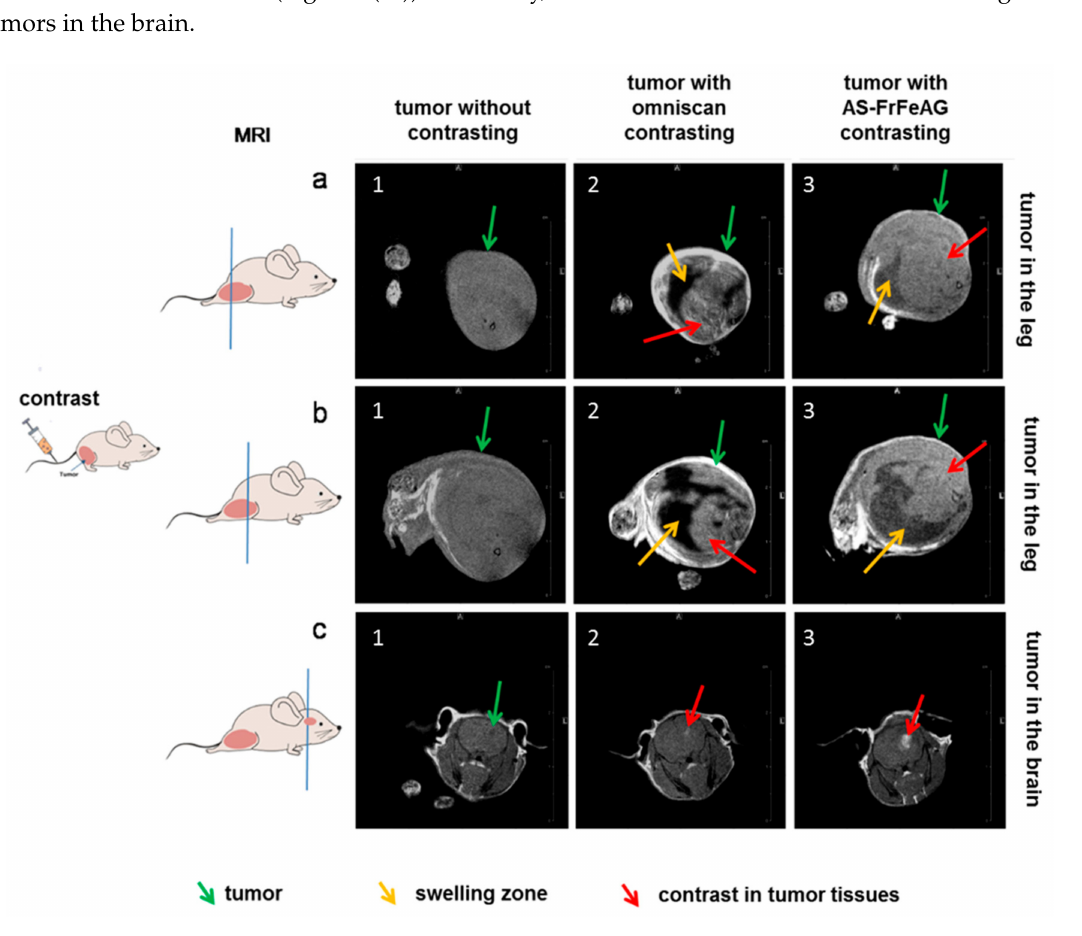
Figure 6. Application of AS-FrFeAG as a contrast agent for tumors in magnetic resonance imaging (MRI). A mice with solid Ehrlich carcinoma transplanted into the right leg ( a , b ) and brain ( c ) without contrasting ( 1 ); with omniscan ( 2 ), and AS-FrFeAG ( 3 ) as a contrast